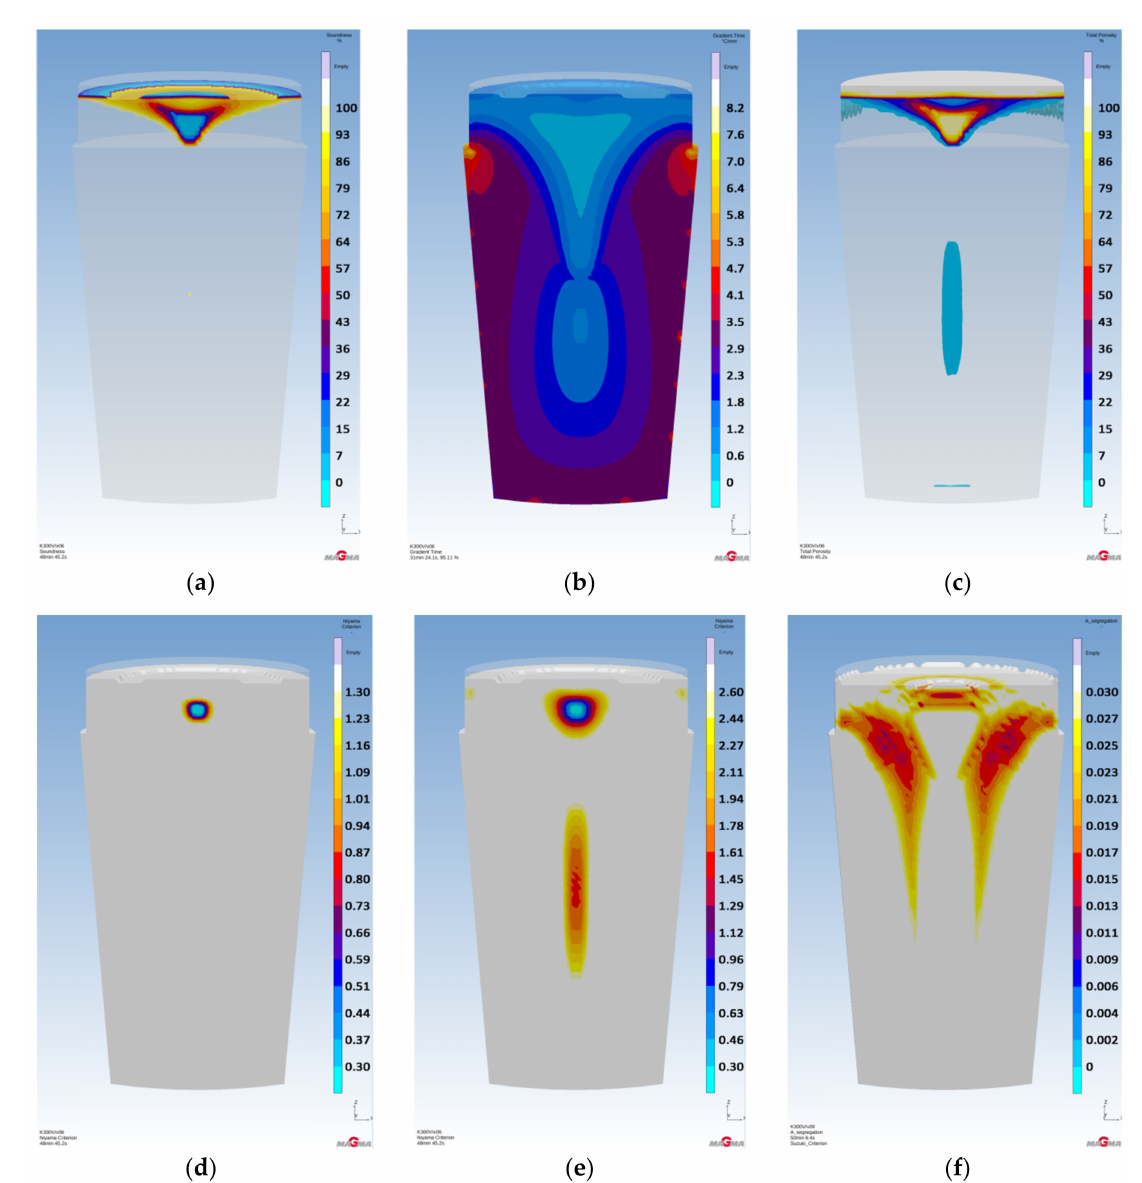
Figure 8. The results of criteria: ( a ) Soundness %; ( b ) Gradient Time 31 min 24.1s; ( c ) Total Porosity %; ( d ) Niyama 0.3–1.3 K 1/2 s 1/2 mm − 1 ; ( e ) Niyama 0.3–2.6 K 1/2 s 1/2 mm − 1 ; ( f ) A-segregation (Suzuki criterion) 0.0–0.03 K s − 1 ( µ m s − 1 ) 1.1